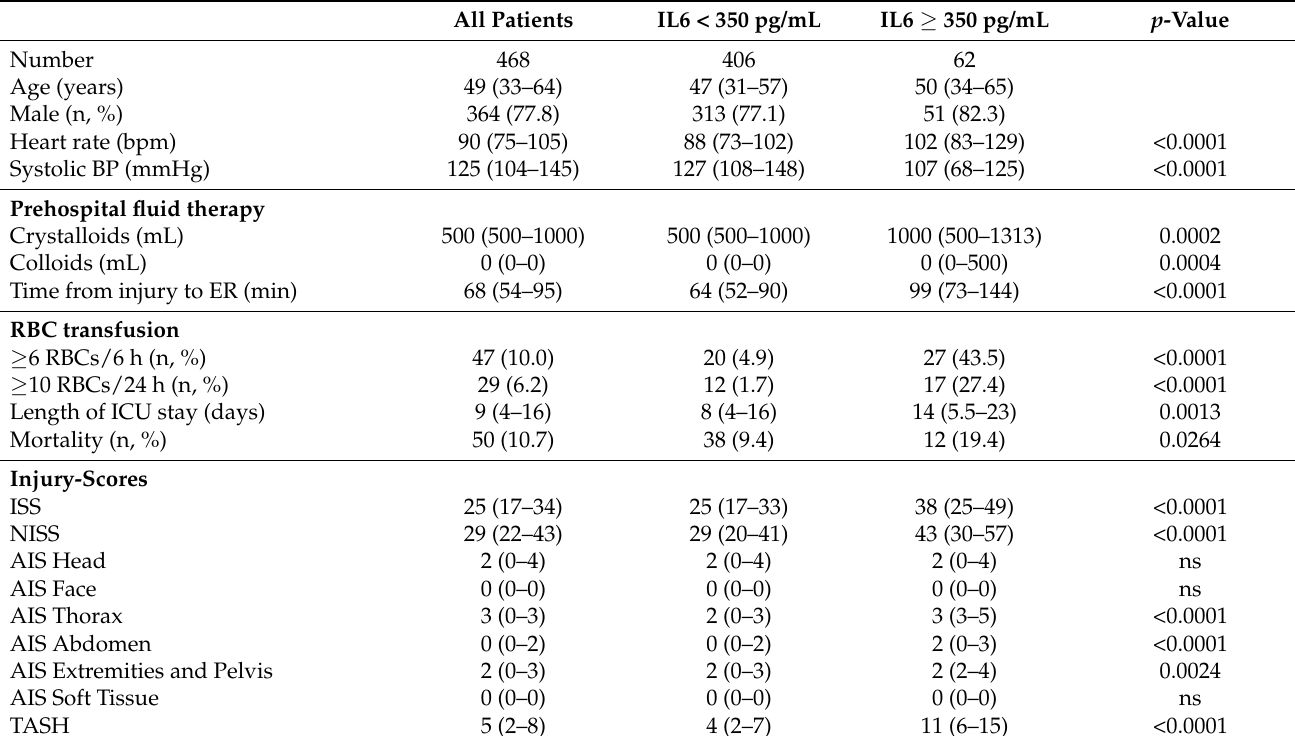
Table 1. Demographics, clinical data, and injury scores upon emergency room admission. All Patients IL6 < 350 pg/mL IL6 ≥ 350 pg/mL p